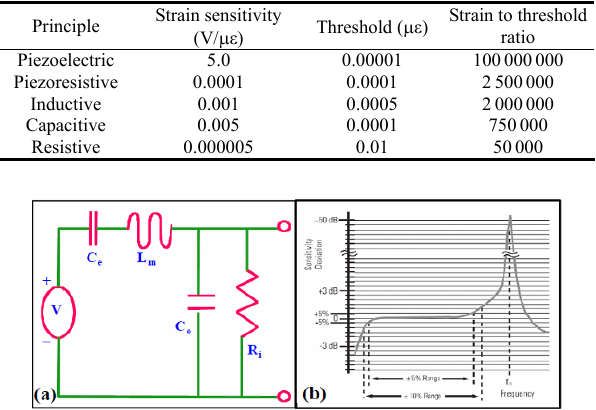
Fig. 7 Schematic symbol of (a) piezoelectric sensor and (b) frequency response of sensor